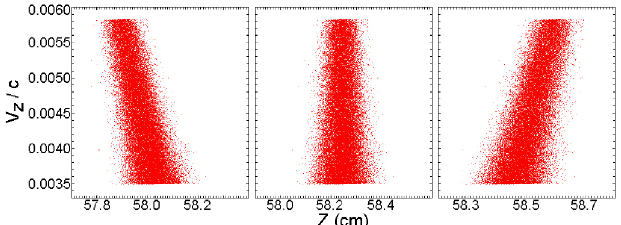
g phase space for the T (cid:4) 0 : 2 eV beam, FIG. 9. (Color) f z; v k z using the sharp waveform across an infinitely thin gap, 2 ns before arrival at the focal plane (left), at the focal plane (center), and 2 ns after passing the focal plane (right). Focus occurs at z (cid:4) (cid:8) 58 : 25 cm and t (cid:4) 950 ns